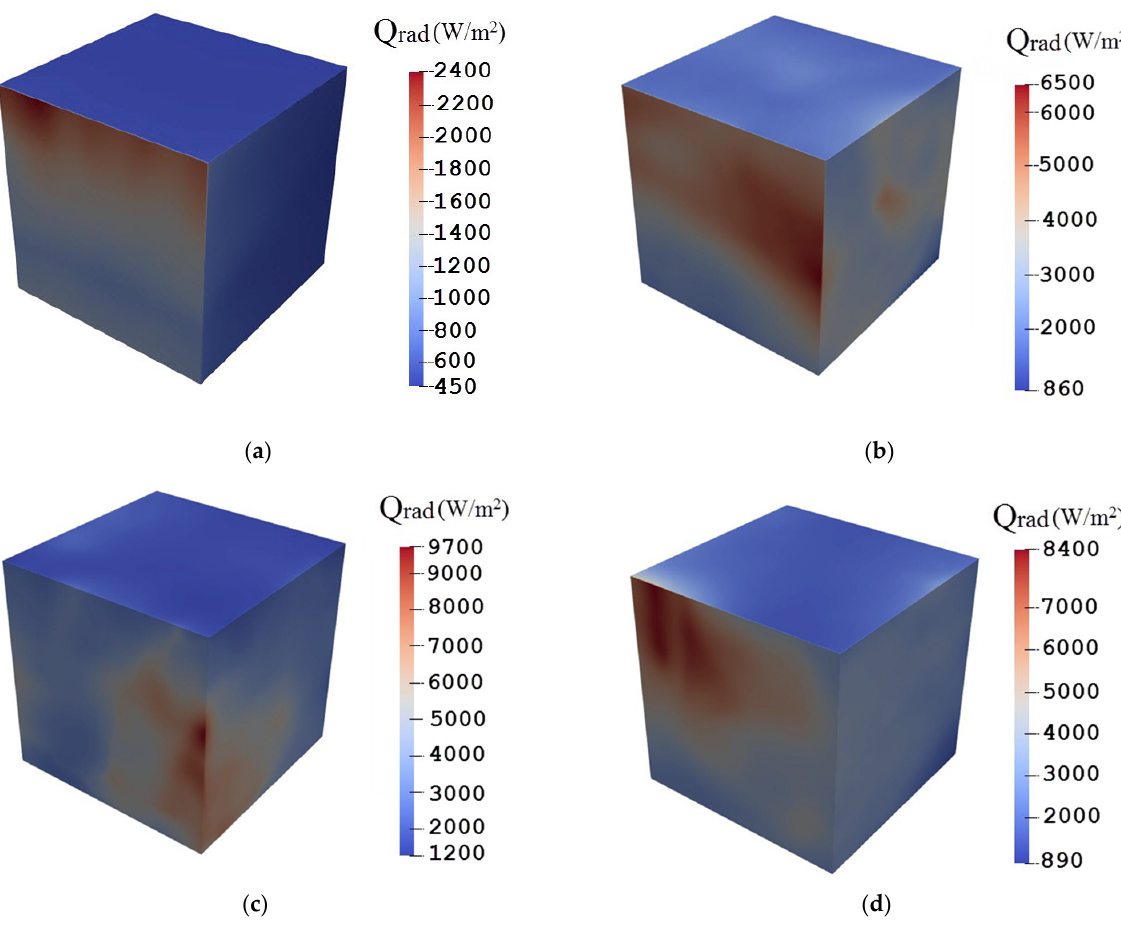
( b ) Figure 6. ( a ) Time history of instantaneous surface temperature; ( b ) frequency spectrum of temperature obtained from fast Fourier transform (FFT) analysis; dominant frequencies are marked with circles. Figure 7 compares the incident radiative heat flux on the building at different times. As expected, the frontal façade of the building receives most of the radiant heat flux over the